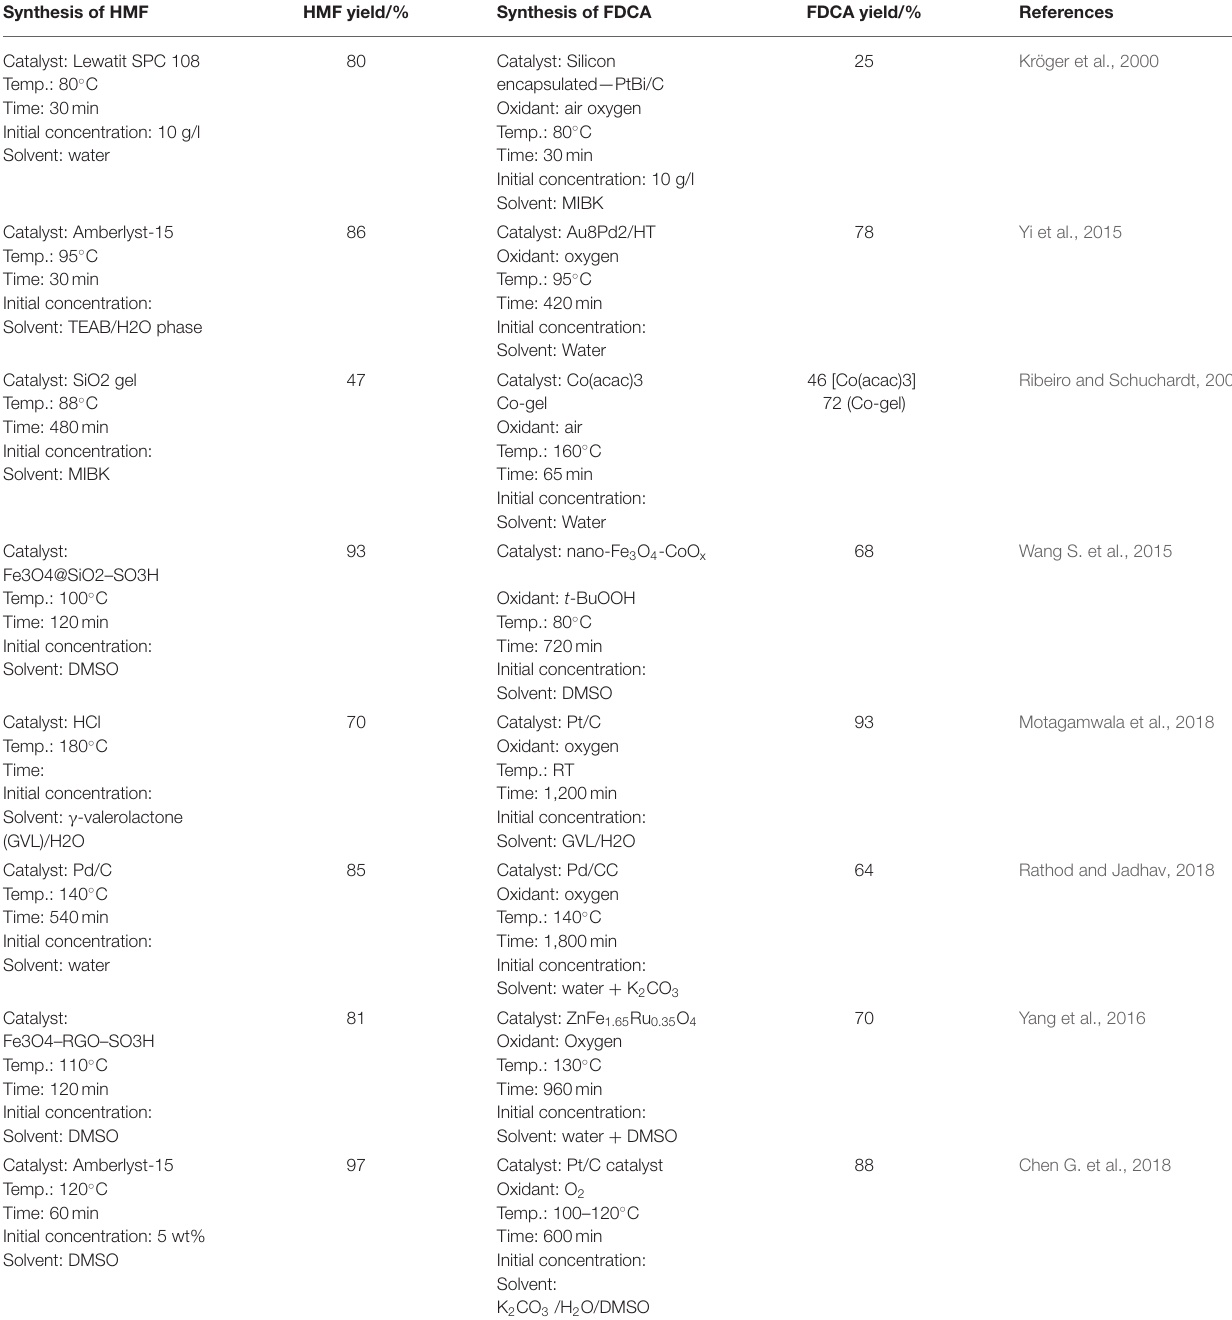
TABLE 6 | Summary of the one-pot two-step methods for the production of FDCA from fructose. Synthesis of HMF HMF yield/% Synthesis of FDCA FDCA